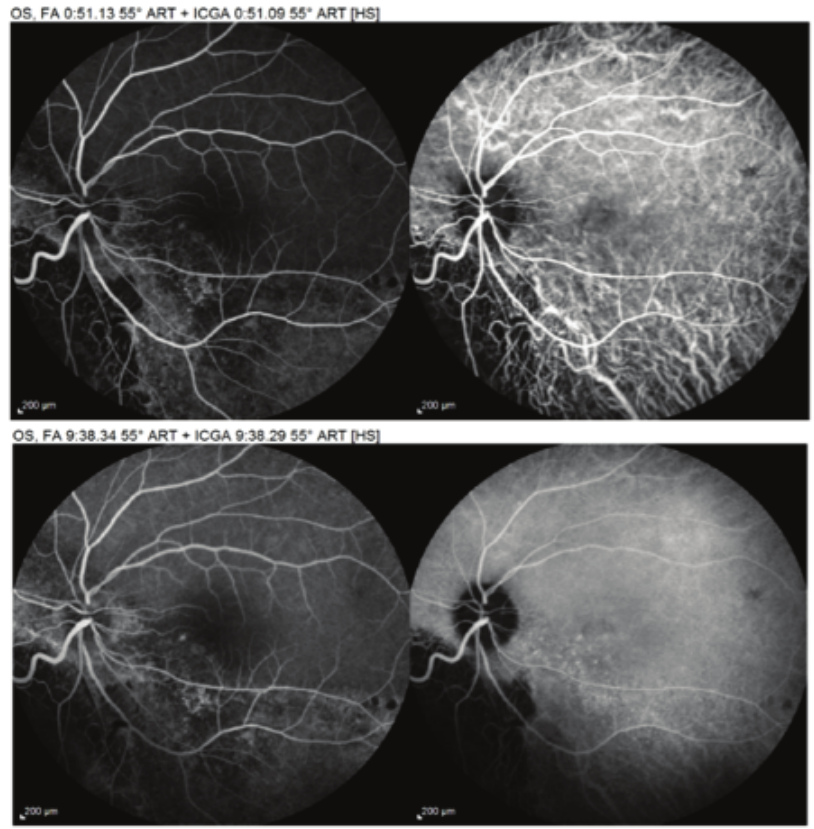
Figure 3. Early and late phases of fluorescein angiography (left) and ICG angiography (right) showing juxtafoveal subretinal leakage in addition to congestion of choroidal vessels.